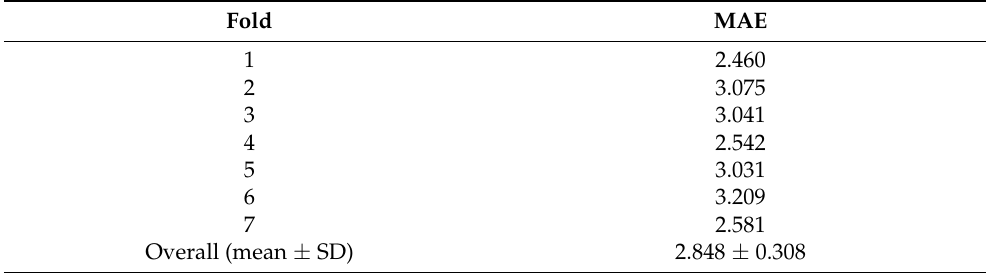
Table 5. The overall MAE of the seven-fold cross validation